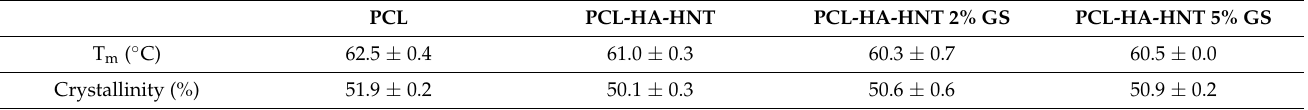
Table 2. DSC analyses results from produced filaments showing T m and crystallinity of PCL ( n =